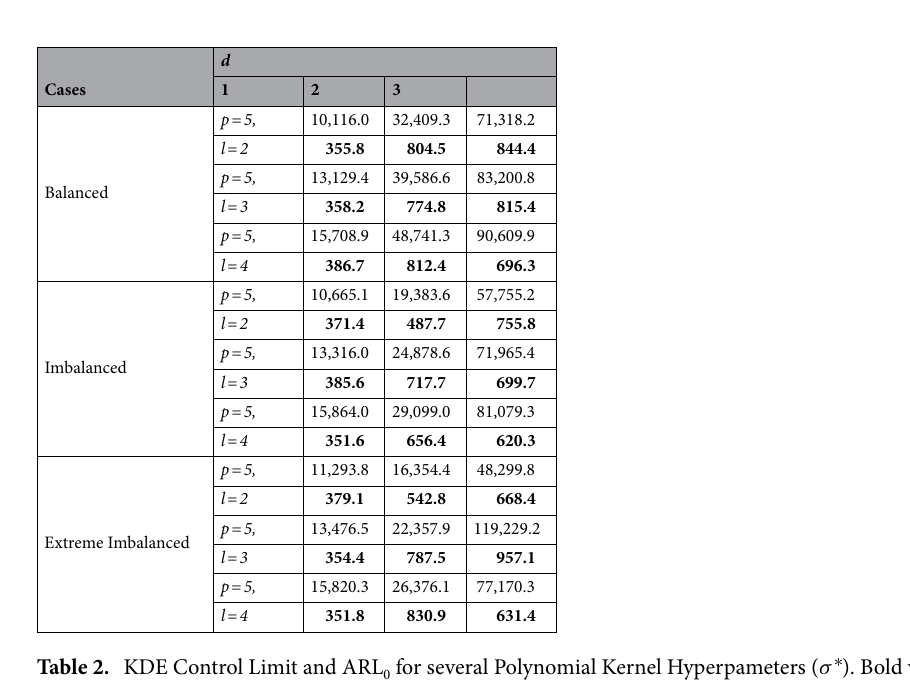
Table 2. KDE Control Limit and ARL 0 for several Polynomial Kernel Hyperpameters ( σ ∗ ). Bold values represent the ARL 0 (In-control